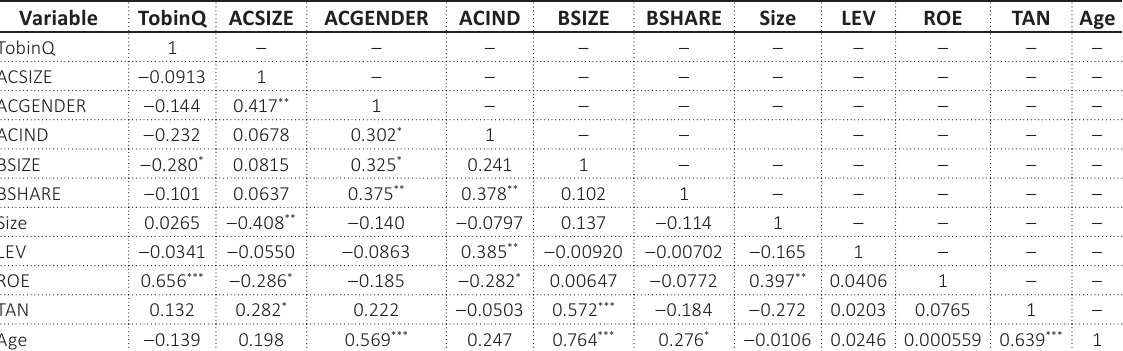
Table 3. Correlation